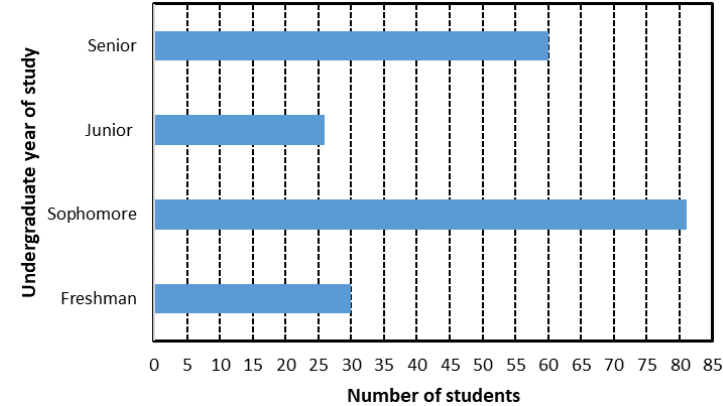
Figure 2. Student sample from 1st to 4th year of college study.